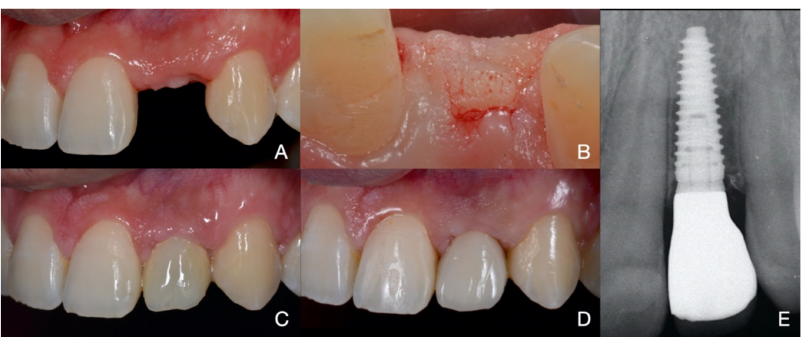
Figure 3. In the edentulous ridge ( A ) is placed an implant in Section 2.2. Six months later, the second stage surgery ( B ) is performed through a mid-crestal flap for the minimal displacement of the keratinized tissue and a provisional screw-retained crown ( C ) is set in place. Three months later the NPS final rehabilitation is delivered. ( D ). On the right ( E ) is the three years